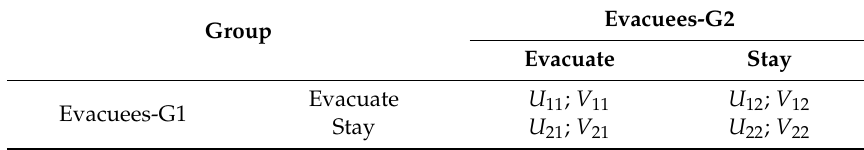
Table 1. Payo ff Matrix of the